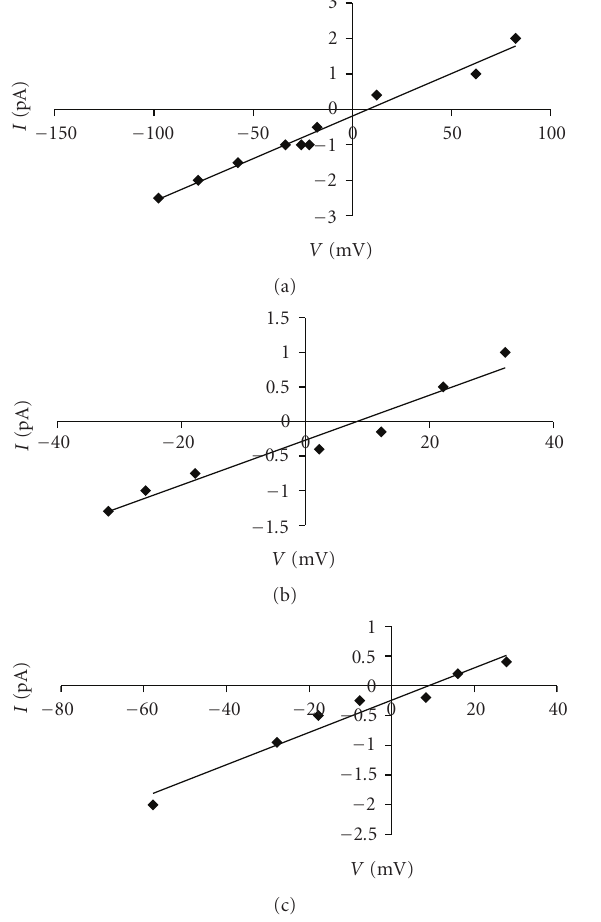
Figure 8: A β P1-40 channel ion selectivity in POPC:Ch PLM. A β P1-40 channel selectivity (a), in the presence of choline (5 × 10 − 11 M) cis (b) or trans (c) side in POPC:Ch (65:35, w/w) PLM. The amplitude of the channel current (pA) is plotted as a function of the transmembrane potential ( V ). Conductance was determined by linear regression of the current values from − 150 to 100mV (a) and from − 40/ − 80 mV to 40/40mV (choline cis / trans ) in asymmetrical 100 mM/50mM KCl cis / trans solutions. Intercept (9.76/5.76/7.76 mV, (a)/(b)/(c) resp.) was used to calculate P K + / P Cl − .